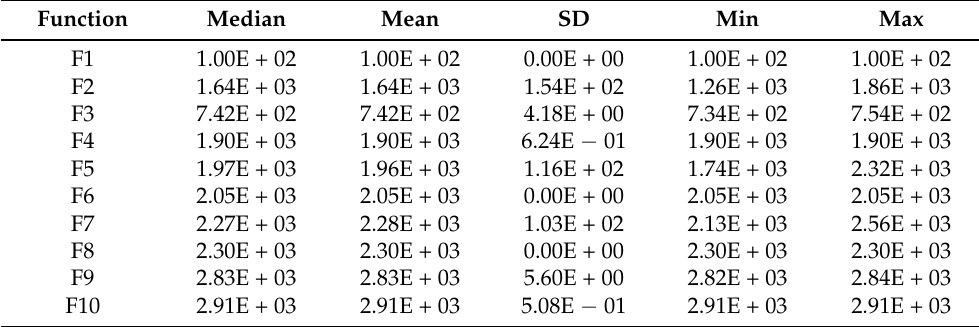
Table 7. The CEC 2020 ( D = 20) function values achieved by SHADE over 50 runs and 50,000 function evaluations.